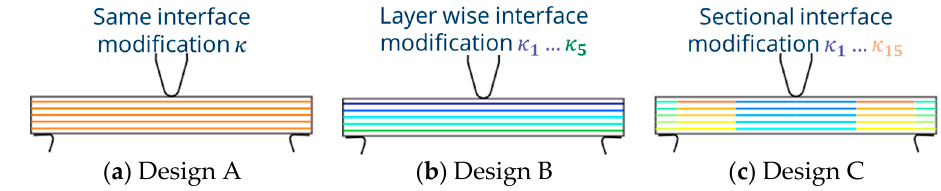
Figure 6. Investigated interface modification designs.